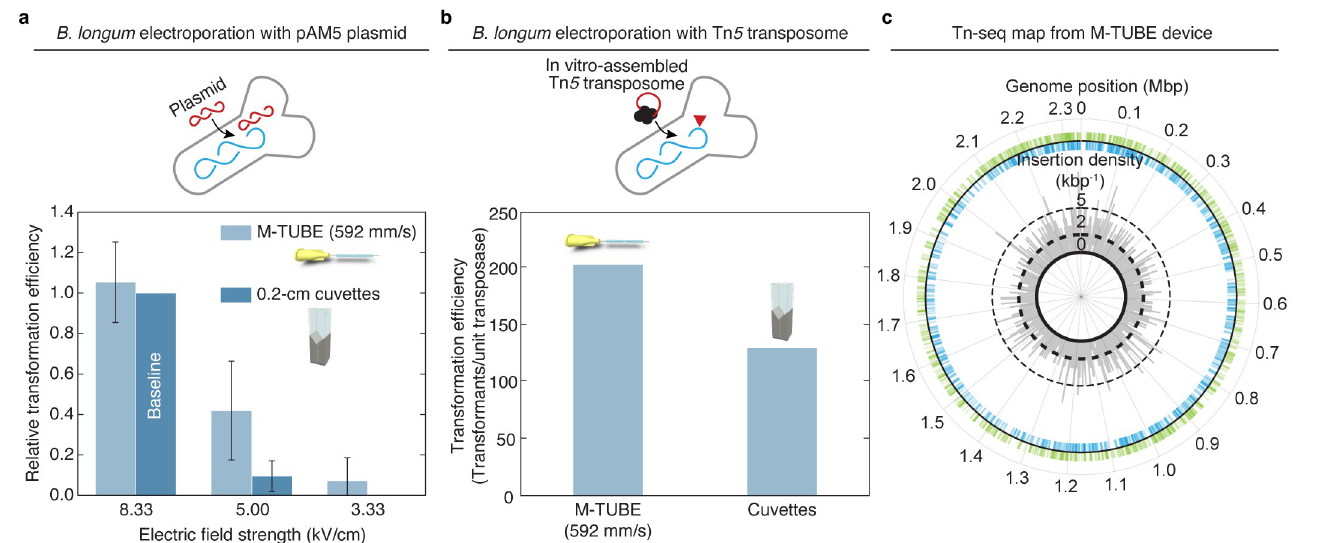
Fig 3. M-TUBE efficiently transforms anaerobic bacteria and enables transposon insertion mutagenesis. (a) Comparison of M-TUBE performance during electrotransformation of B . longum NCIMB8809 with the plasmid pAM5 at various electric field strengths. For M-TUBE devices, voltages of ± 2.50, ± 1.50, and ± 1.00 kV (AC field) were applied to produce electric fields of 8.33, 5.00, and 3.33 kV/cm, respectively. A fluid velocity of 592 mm/s was used for the M-TUBE device because approximately 5 ms residence time with an M-TUBE ID of 0.5 mm is similar to the time constant observed in cuvette electroporation (5.2–5.6 ms). Data represent the average ( n � 3) and error bars represent 1 standard deviation. (b) Comparison of M-TUBE performance during electrotransformation of B . longum NCIMB8809 with Tn 5 transposome. For the M-TUBE device, a field strength of 8.33 kV/cm and fluid velocity of 592 mm/s were used, motivated by the results in (a). (c) The transposon insertions recovered from Tn 5 transposome electroporation are spread approximately uniformly across the B . longum NCIMB8809 genome. The locations of individual mapped insertions are recorded on the outer circle. Green ticks on the outside indicate insertions in the positive (+) orientation, blue ticks on the inside indicate insertions in the negative ( − ) orientation. The insertion density (kbp − 1 ) (both positive and negative orientation) is plotted in 1-kbp bins on the inner circle. Transposon insertions are distributed throughout the genome in both the positive and negative orientations, indicating that B . longum NCIMB8809 can be transformed by Tn 5 transposomes using M-TUBE without major insertional bias. The data underlying this figure can be found in S2 Data. AC, alternating current; ID, inner diameter; M-TUBE, microfluidic tubing-based bacterial electroporation.